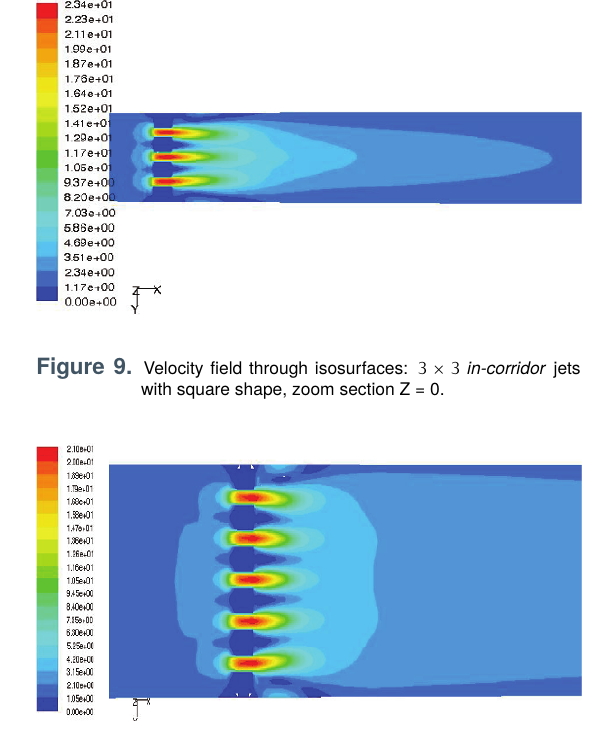
Figure 10. Velocity field through isosurfaces: 5x5 in-corridor jets with square shape, zoom section Z=0.